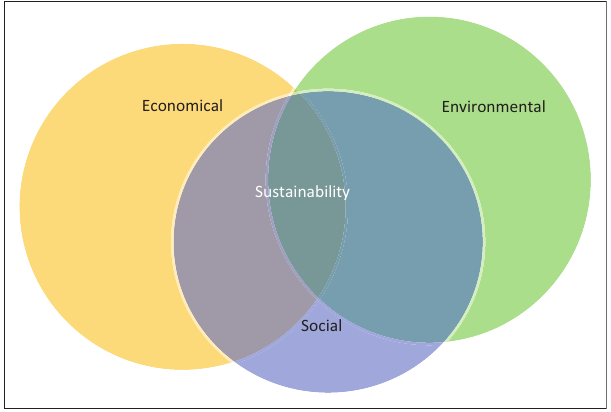
FIGURE 1: Relationship between green logistics and socio-economic environmental